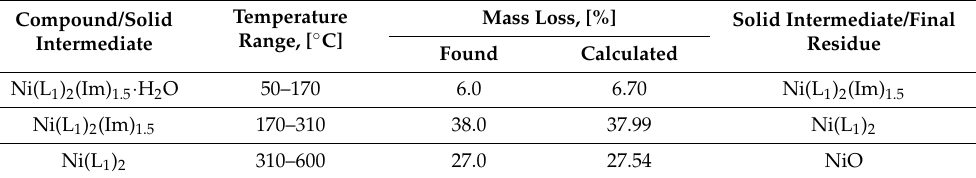
Table 5. TG-DTG analysis data of decomposition of Ni(L 1 ) 2 (Im) 1.5 · H 2 O.